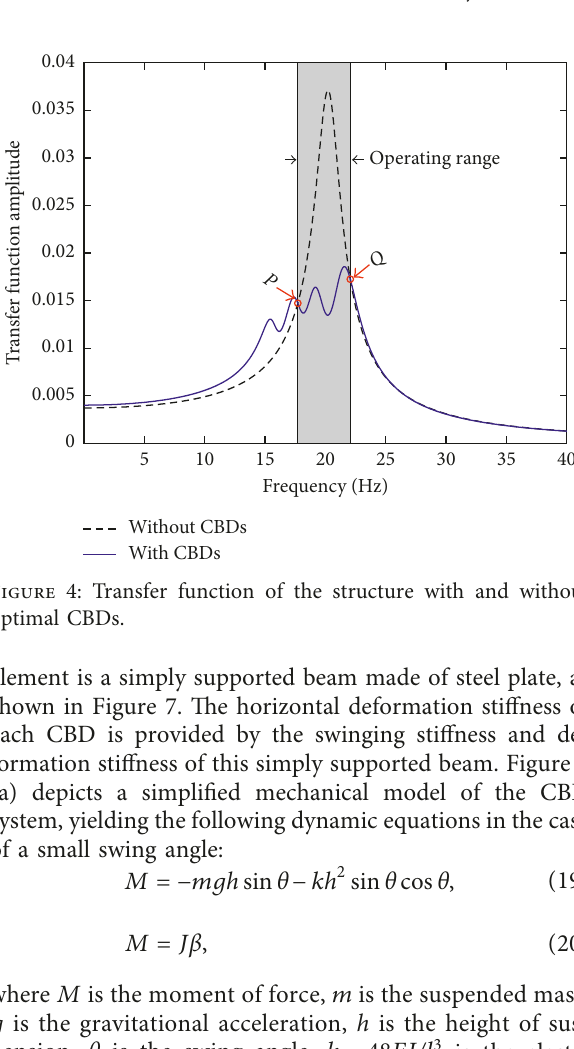
Figure 3: The main vibration control mode of the subject structure.